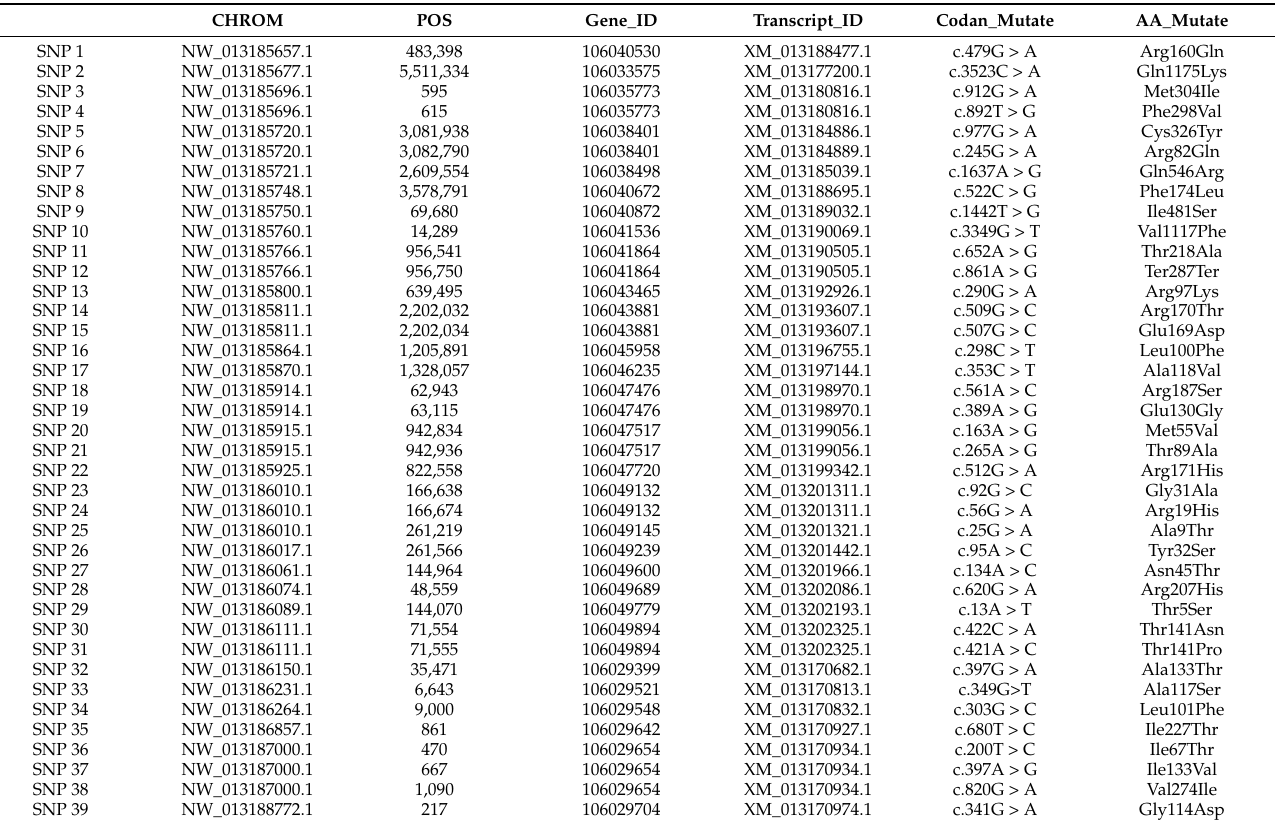
Table 3. A total of 39 candidate SNPs were screened in this